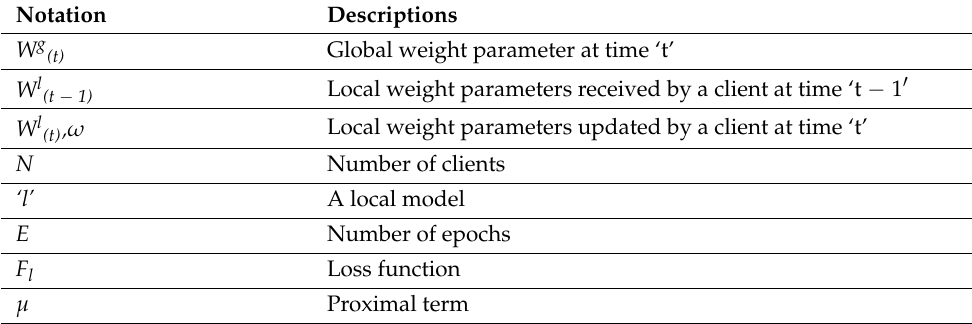
Table 1. Terminologies used in the